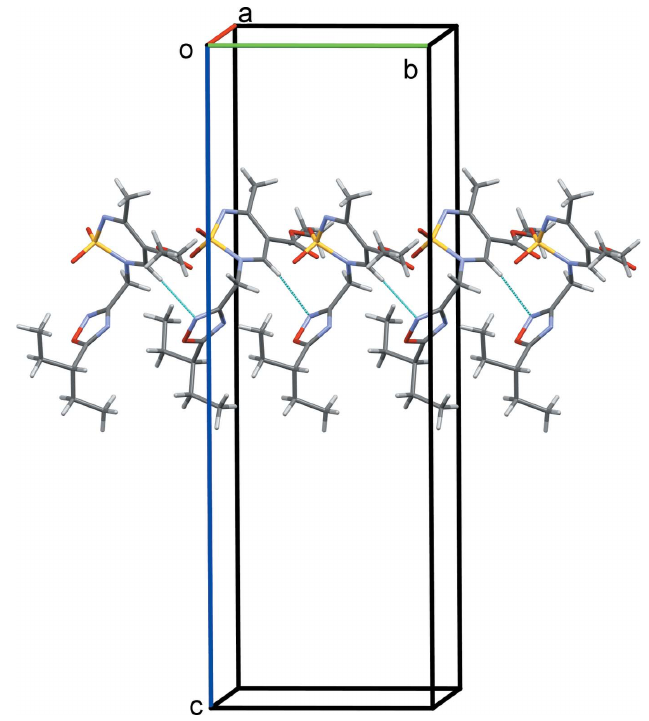
Figure 4 A partial view along the a axis of the crystal packing of compound 3 . Hydrogen bonds (Table 1) are shown as dashed